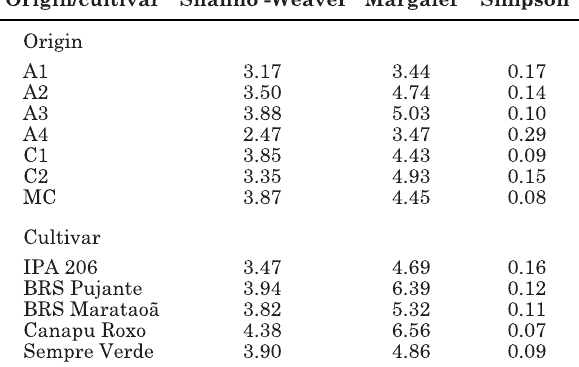
Table 6. Shannon-Weaver diversity, Margalef richness and Simpson dominance indexes of rhizobium isolated from five cowpea cultivars in soils of the lower half of the São Francisco river